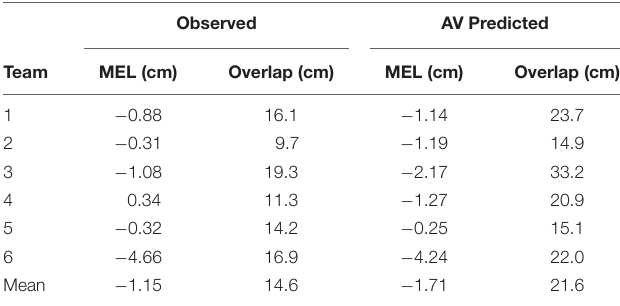
TABLE 2 | Logistic regression results for observed and predicted interception